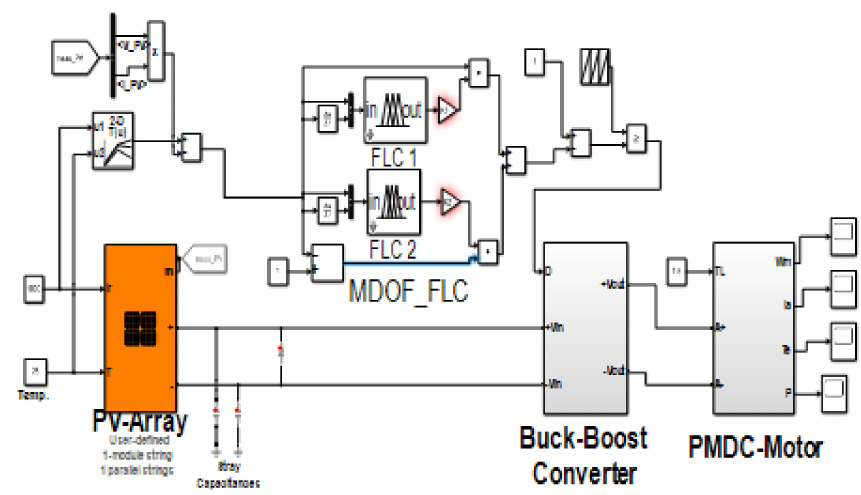
Figure 13. Simulink model of the system with the MDOF-FLC.